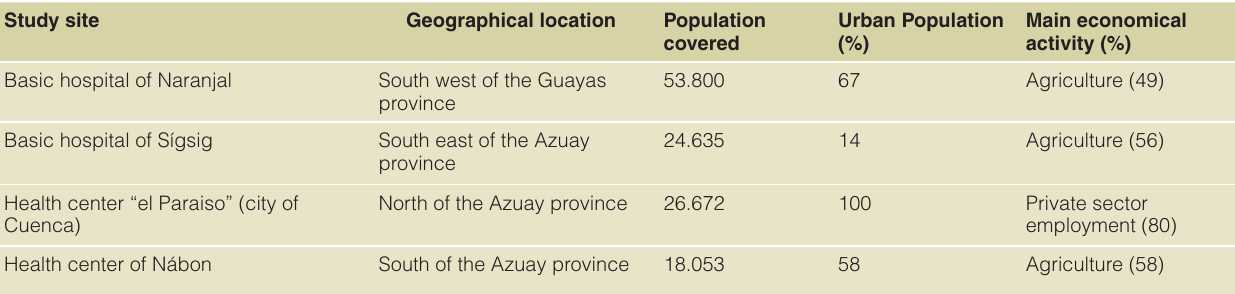
Table 1. Basic characteristics of the population covered by each health